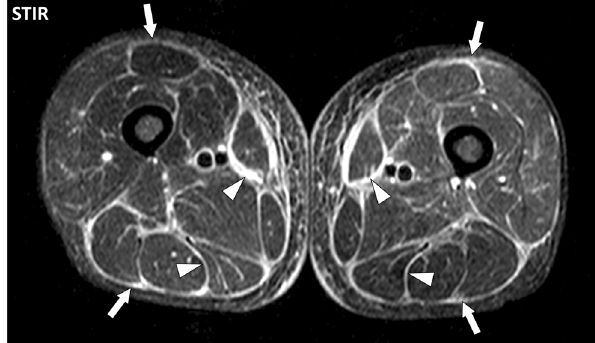
Fig. 10 Axial STIR image of the thighs of a 50-year-old male with eosino- philic fasciitis. MRI demonstrates bilateral symmetrical diffuse involvement of the deepperipheralfasciae(arrows)anddeepintermuscularfasciae(arrow- heads), whichare thickenedwithhighsignal intensity.Thefasciasuperficialis is barely involved and the signal of the muscles is normal